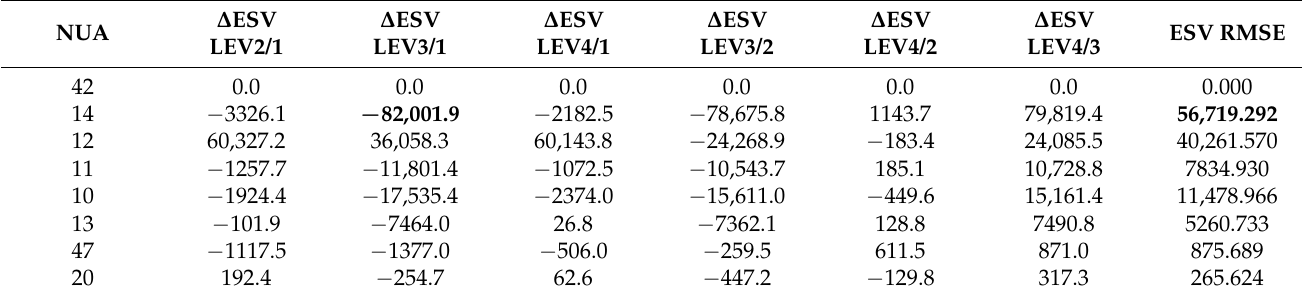
Table 5. Higher NUA assessment variations in real units (>|100| for ESV) among scenarios. Bold numbers represent maximum